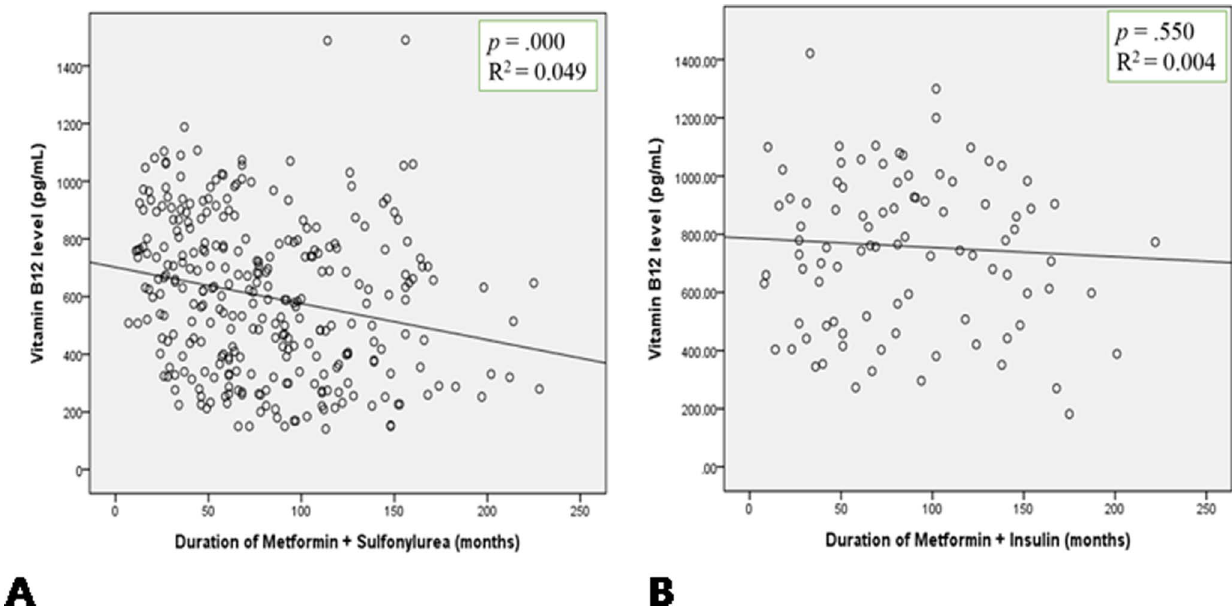
Figure 1. Correlation between the vitamin B 12 levels and the duration of metformin treatment in two different groups. A: S + M group, B: I + M group. R 2 : coefficient of determination.